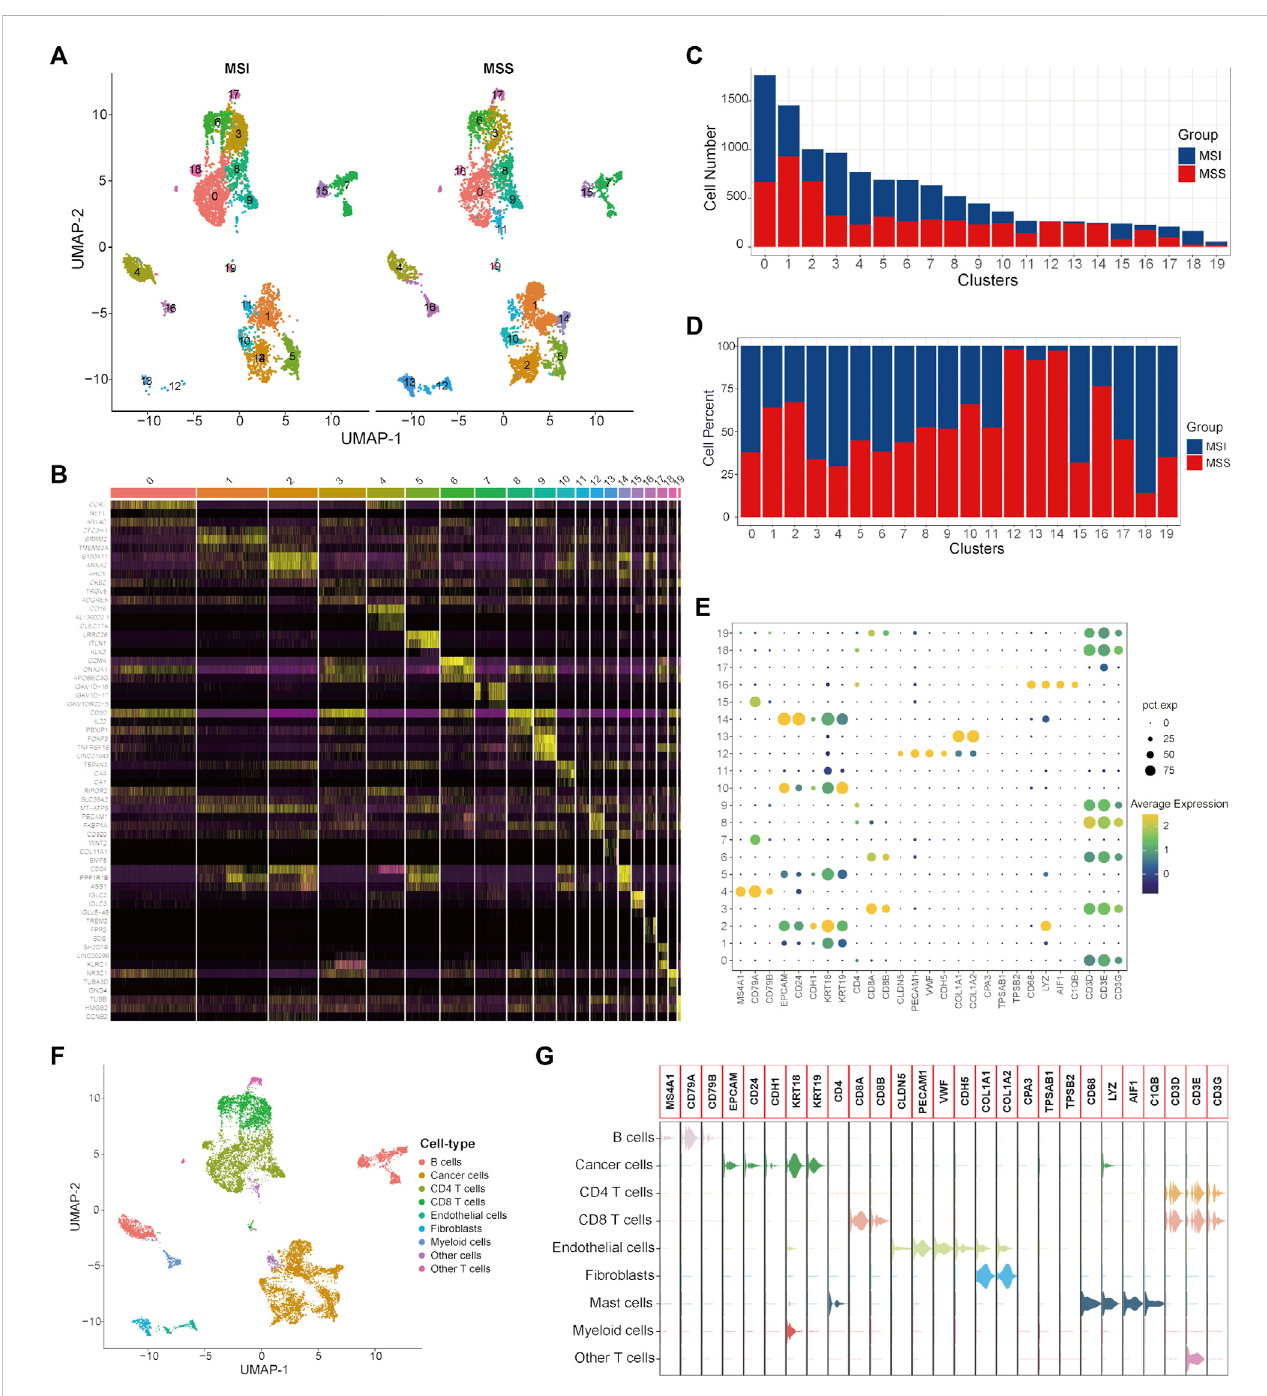
FIGURE 3 Single-cellatlasofMSIandMSSCRCpatientsinthescRNAvalidationcohort. (A) UMAPandclusteranalyses(Clusters0 – 19)of5555singlecellsfromCRC patients with MSI status and 5665 cells with MSS status. (B) The heatmap visualizes the top three signi fi cantly highly expressed genes in each cell cluster. (C) Cell numbers of MSI and MSS CRC-derived cells in these 20 cell clusters. (D) Cell proportions of MSI and MSS CRC-derived cells in these 20 cell clusters. (E) Dot plots visualize the speci fi c cell marker genes in each cell cluster. (F) UMAP plot of cell annotation results. (G) Violin plots of the speci fi c cell marker